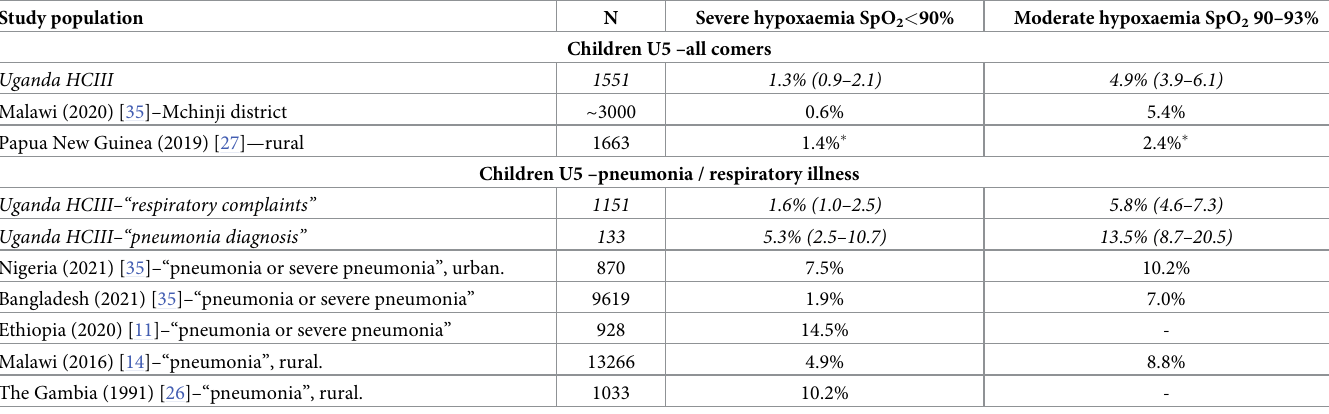
Table 3. Comparison of U5 hypoxaemia prevalence findings with other studies in primary care settings. Study population